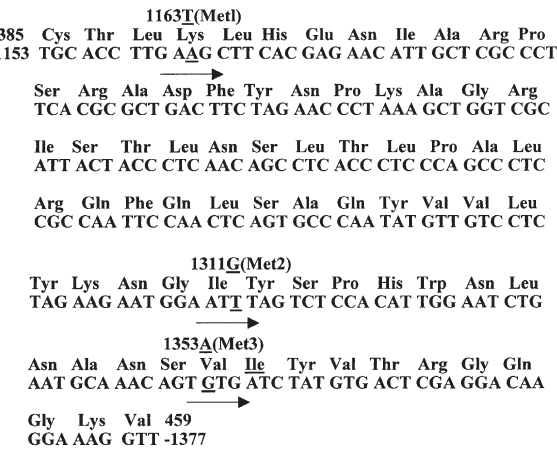
Figure2 -NucleotideandaminoacidsequencecomparisonsofGy4genes and proteins. Only nucleotides +1153 to +1377 and translated amino acids 385 to 459 are shown. Arrows refer to the nucleotides that have been mu- tated in the Gy4. + 1153 and +1377 mean the order of these nucleotides from the start code